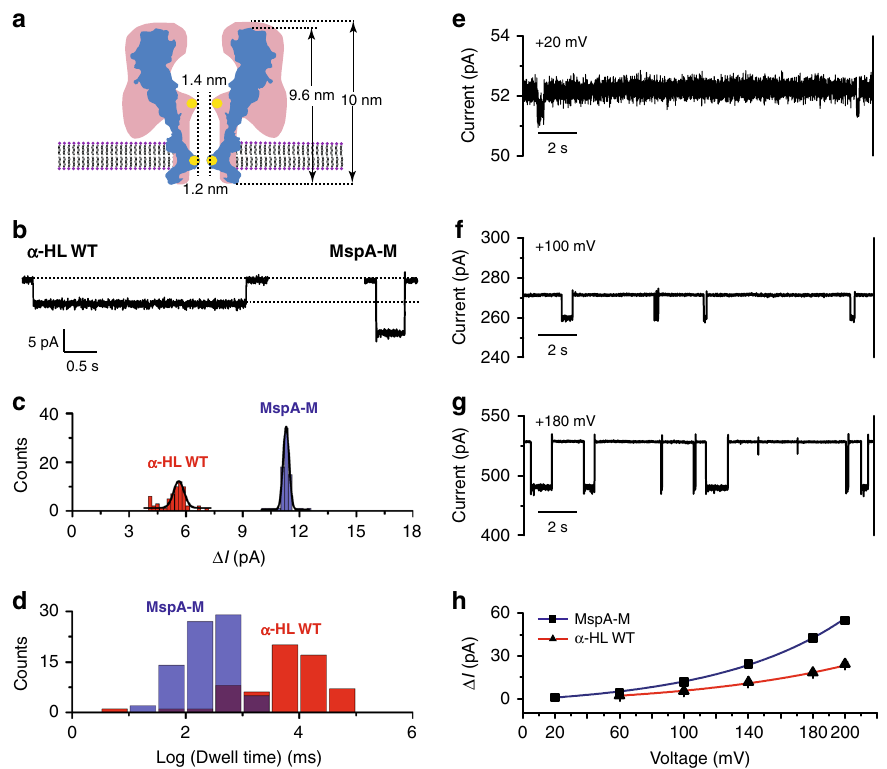
Fig. 2 Comparison between WT α -HL and MspA-M for single [AuCl 4 ] − sensing. a Geometric comparison between WT α -HL (red) and MspA-M (blue). Yellow spots indicate the location of methionine in the pore. b Representative binding events from a single [AuCl 4 ] − within a WT α -HL or a MspA-M nanopore at + 100mV, respectively. c Event-amplitude ( Δ I ) histograms with Gaussian fi tting for single [AuCl 4 ] − bindings within a WT α -HL (red) or an MspA-M (blue) nanopore. The [AuCl 4 ] − sensing performance is signi fi cantly improved with MspA-M showing a deeper blockage depth and a narrower distribution width (WT α -HL: 5.6± 0.3 pA; MspA-M: 11.3 ±0.2 pA) . d Log dwell-time histograms for WT α -HL (red) and MspA-M (blue) for single [AuCl 4 ]